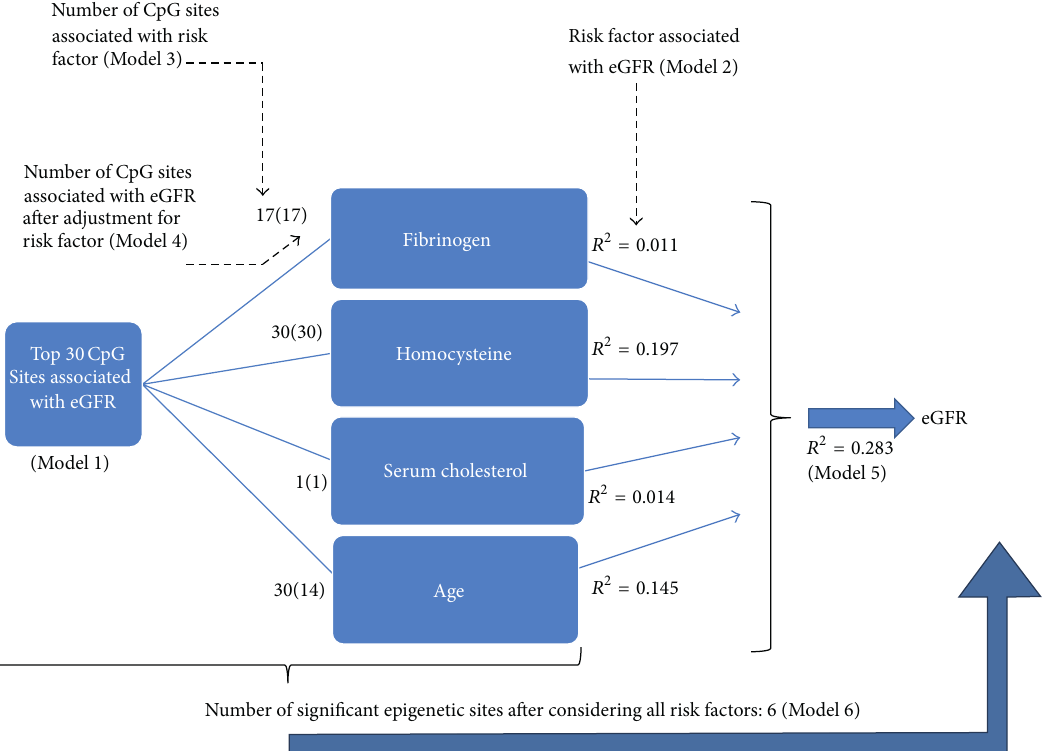
Figure 1: Flow chart of the contributions of all models used in this study and their relationships with eGFR.